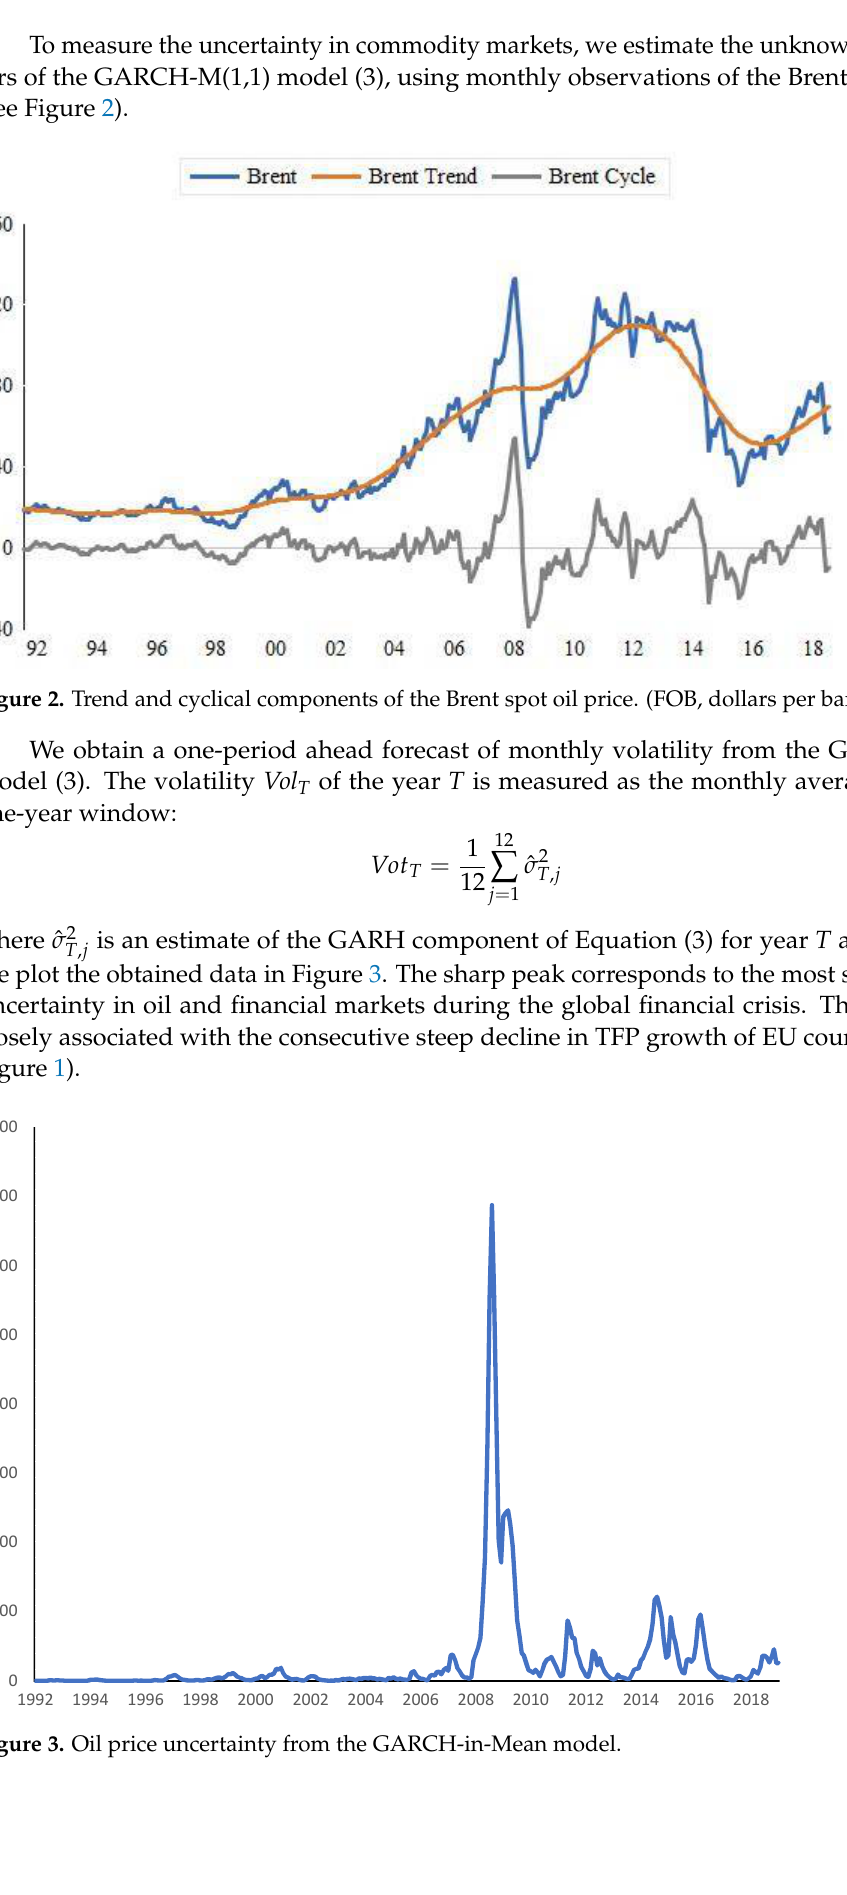
Figure 3. Oil price uncertainty from the GARCH-in-Mean model. The model key variables’ description and summary statistics are reported in Table 1. Table 1. Variable’s description and descriptive statistics.